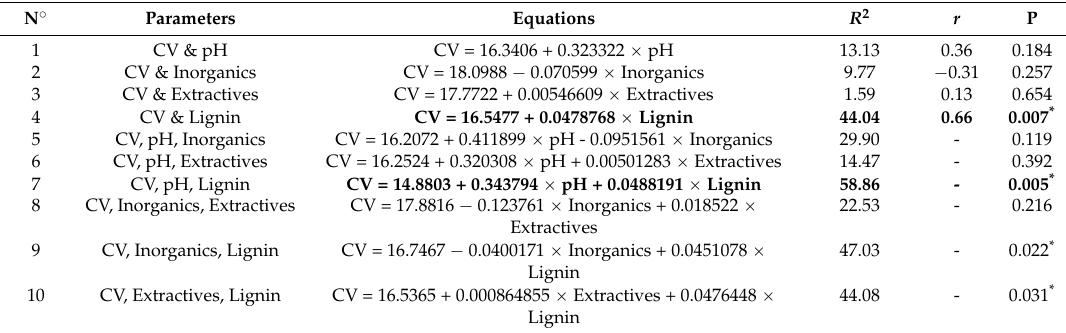
Table 3. Equations of linear regression and multiple correlations between calorific value (CV) and chemical constituents of the studied timber species of the Mexican semi-arid